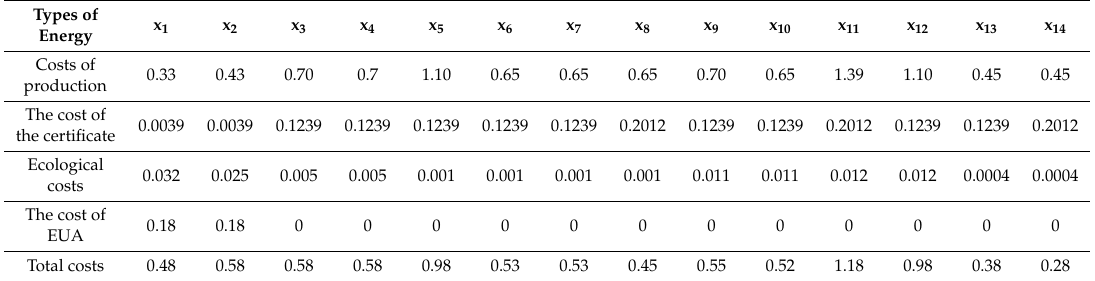
Table 14. Cost factors for each type of energy source (in PLN / kWh) according to scenario II. Types of